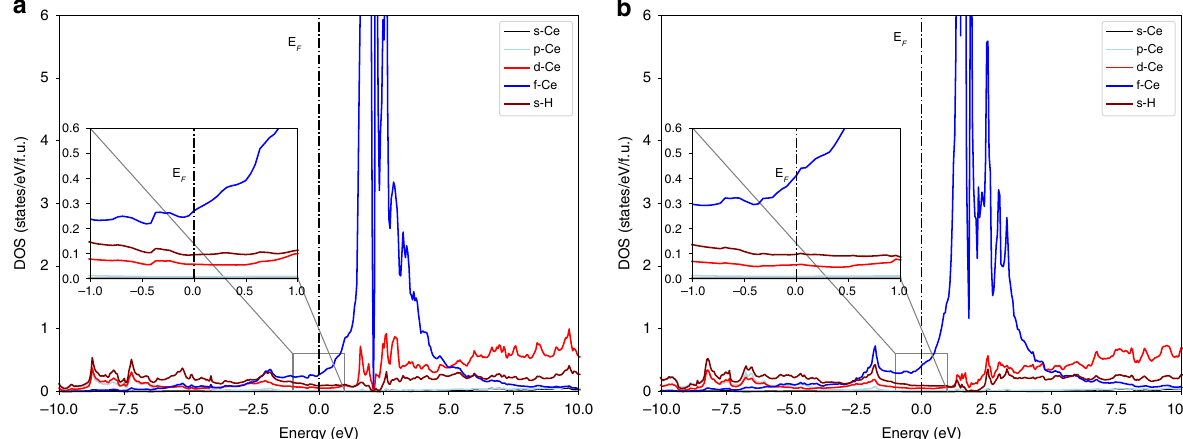
Fig. 8 Electron density of states (DOS) for CeH 9 at 150 GPa. a and b represents electron DOS computed with and without Hubbard correction respectively. Electron DOS at the Fermi level is largely dominated by Ce-4 f and H